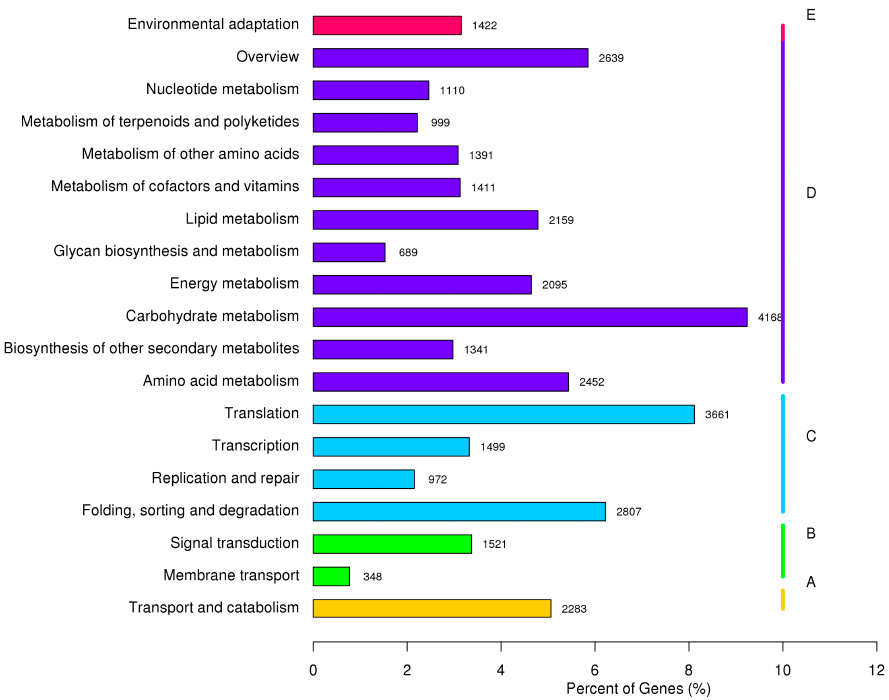
Figure 3. A KEGG classification of the T. foenum-graecum unigenes ( A ) Cellular Processes; ( B ) Environmental Information Processing; ( C ) Genetic Information Processing; ( D ) Metabolism, and ( E ), Organism Systems.